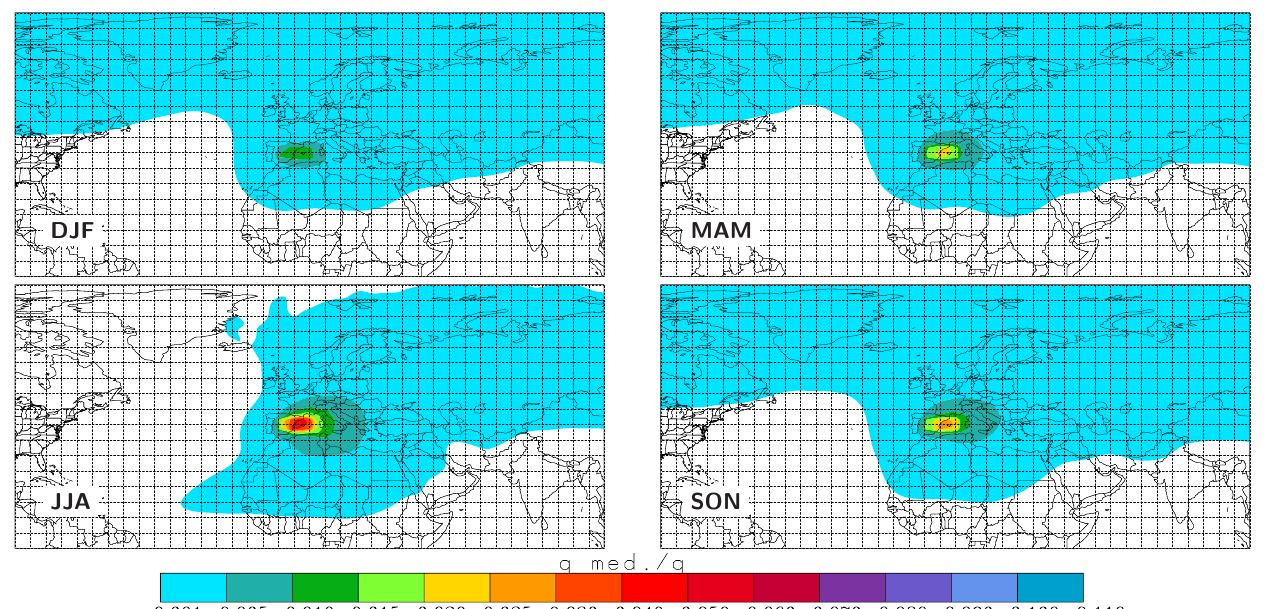
Fig. 10. Same as Fig. 7 (moisture ratio) but for the Balearic